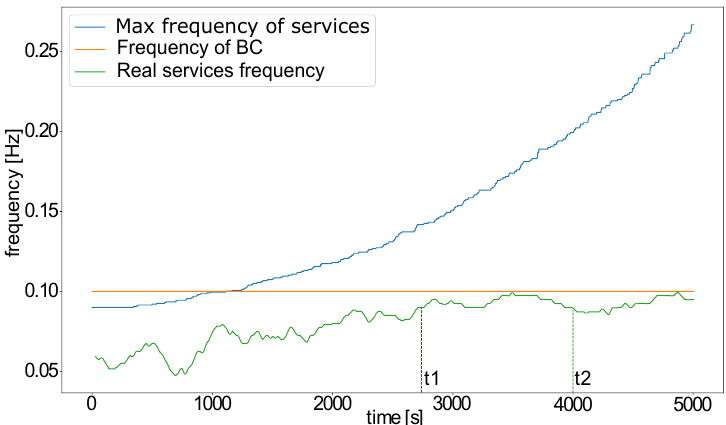
Figure 7. Frequency of service provision over